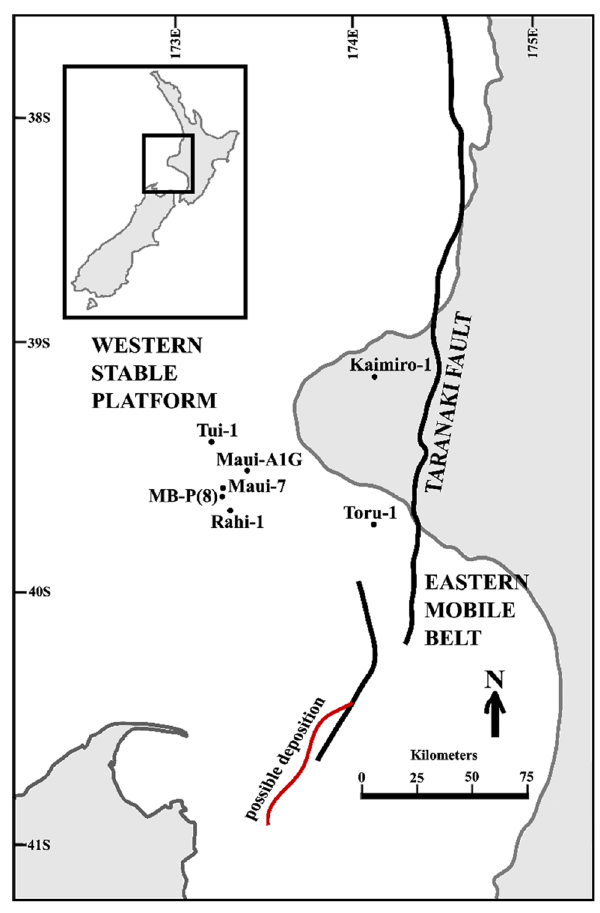
Fig. 1 Location of the Taranaki Basin and the studied wells, modified after Ministry of Business, Innovation and Employment, New Zea- land (2014) and Palmer